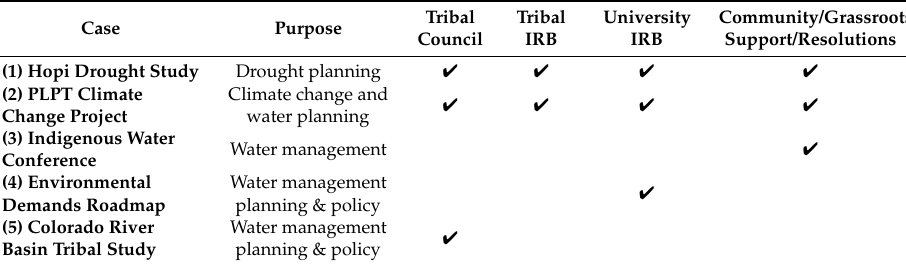
Table 2. Tribal and research approvals received by case